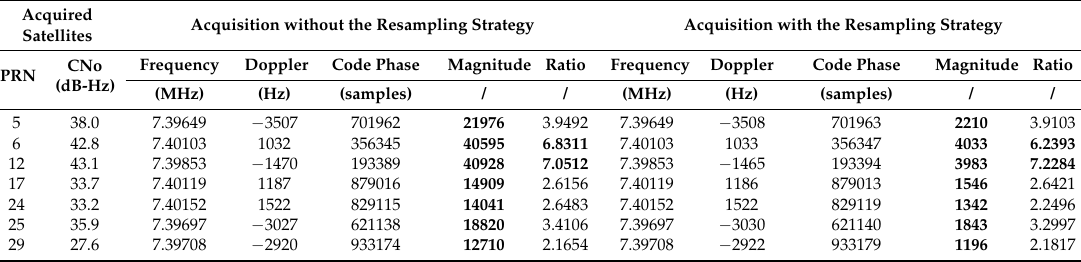
Table 2. Acquisition results of the received signal in Dataset 1 without/with the resampling strategy. Acquired Satellites